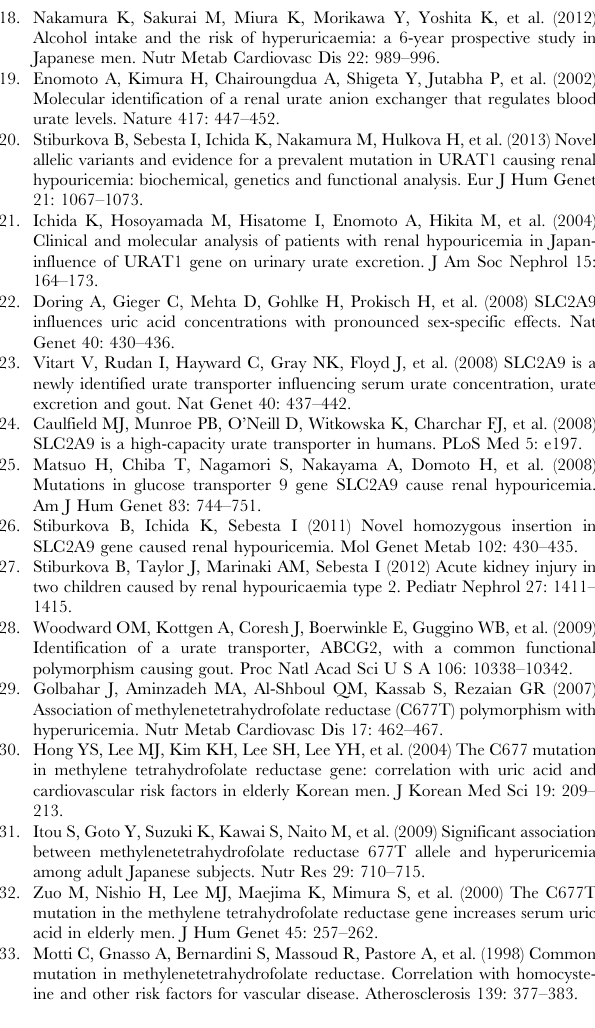
Table S1 Genotype analysis - arrangement and prim- ers. The selected genotypes were determined using multiplex ARMS-PCR. The amplifications were performed in the total volume 10 m l using Combi PPP master mix (Top-Bio s.r.o., Prague, Czech Republic) supplied with allele specific primer pairs